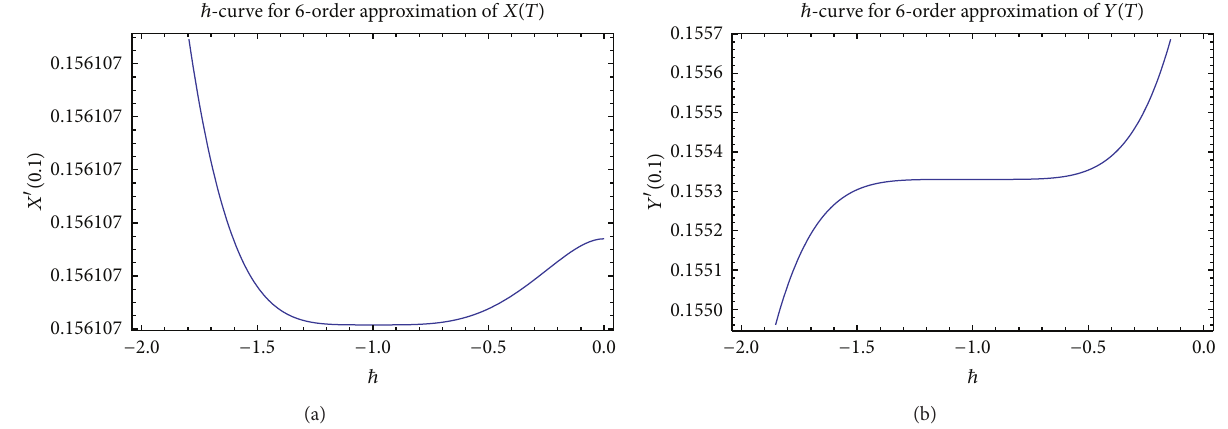
Figure 3: The ℏ -curves of 𝑋 󸀠 (0.1) and 𝑌 󸀠 (0.1) obtained by the 6-order approximation of